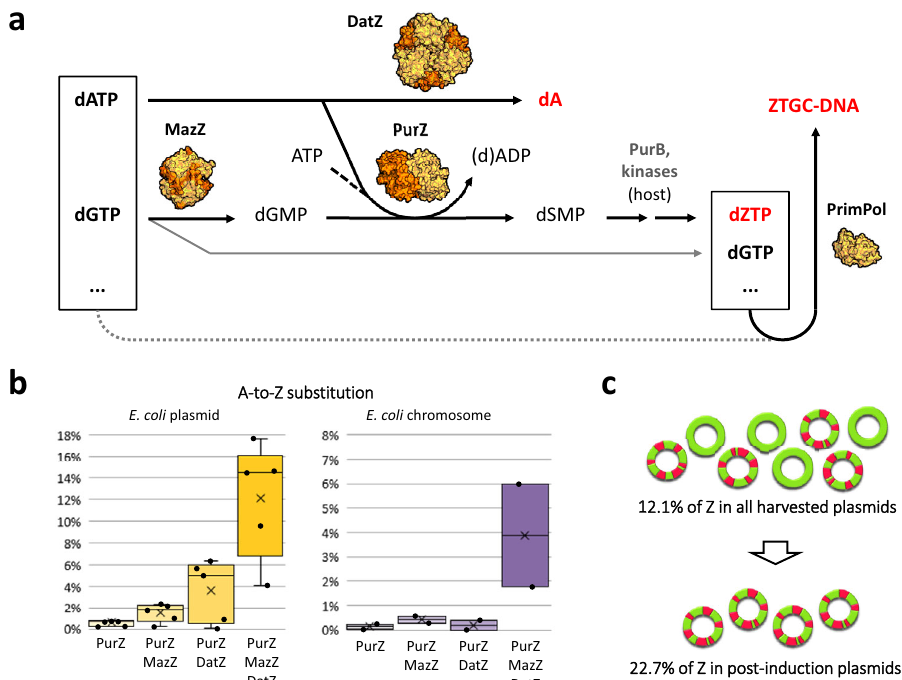
Fig. 4 Metabolic pathway of 2-aminoadenine in S-2L phage and result of its introduction in E. coli . a Native cellular pool of nucleotides is represented in the box to the left; nucleotide pool modi fi ed through expression of the viral Z-cluster is shown on the right. Three dots represent unmodi fi ed dTTP and dCTP. Structures of S-2L proteins solved in this and previous work 13 are shown next to their respective reaction arrows (to scale). Host enzymes (names in grey) fi nalize the dZTP pathway 12 . The dotted grey arrow stands for potential use of the standard dNTP pool by PrimPol in the absence of the Z-cluster. b A-to-Z substitution rates in bacterial plasmidic and chromosomal DNA, obtained after complete or partial transplantation of S-2L Z-cluster to E. coli (labels below). Box plot representation highlights data distribution, while black points denote individual expression results (pentaplicates for plasmidic DNA, duplicates for chromosomal DNA). Box whiskers delimit the range of values, box edges mark upper and lower quartiles, vertical lines represent the median, and black crosses — the average. c Accounting for the pre-induction fraction of ATGC-DNA, roughly every fourth plasmidic adenine (green) was changed to 2-aminoadenine (pink) after expressing the